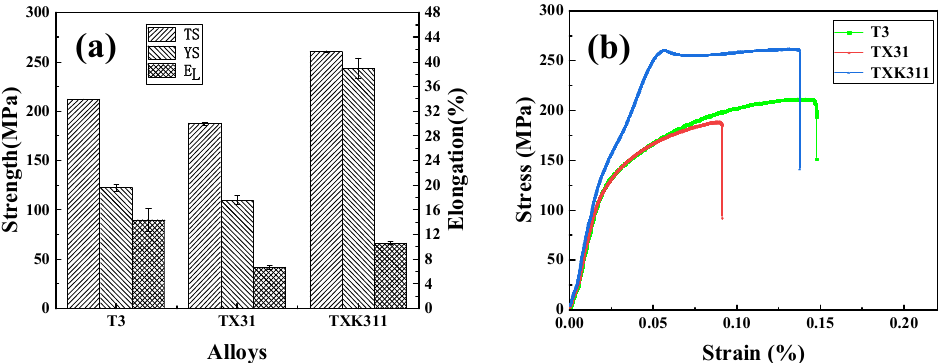
Figure 7. Mechanical properties of as-extruded T3, TX31, and TXK311 alloys at room temperature: ( a ) Mechanical properties diagram, ( b ) Engineering tensile stress–strain curves. Generally speaking, grain size, second phase, texture, or grain orientation are impor- tant factors that affect the yield strength and ductility of Mg alloys [44]. Research shows that grain refinement will lead to the increase of grain boundaries, making the transmission of dislocations difficult, thus improving the strength of the alloy [45]. According to Hall Petch formula, the yield strength of materials is expressed as a function of grain size, as shown in Formula (1) [46]. where: σ s is the yield strength, σ 0 is the friction stress, K is the constant, and d is the average grain diameter. Obviously, the yield strength is inversely proportional to the grain size, and fine grains can improve the yield strength of the alloy. Assume that all as-extruded alloys in this study σ 0 is the same as K value, then the increase in yield strength caused by grain refinement can be expressed